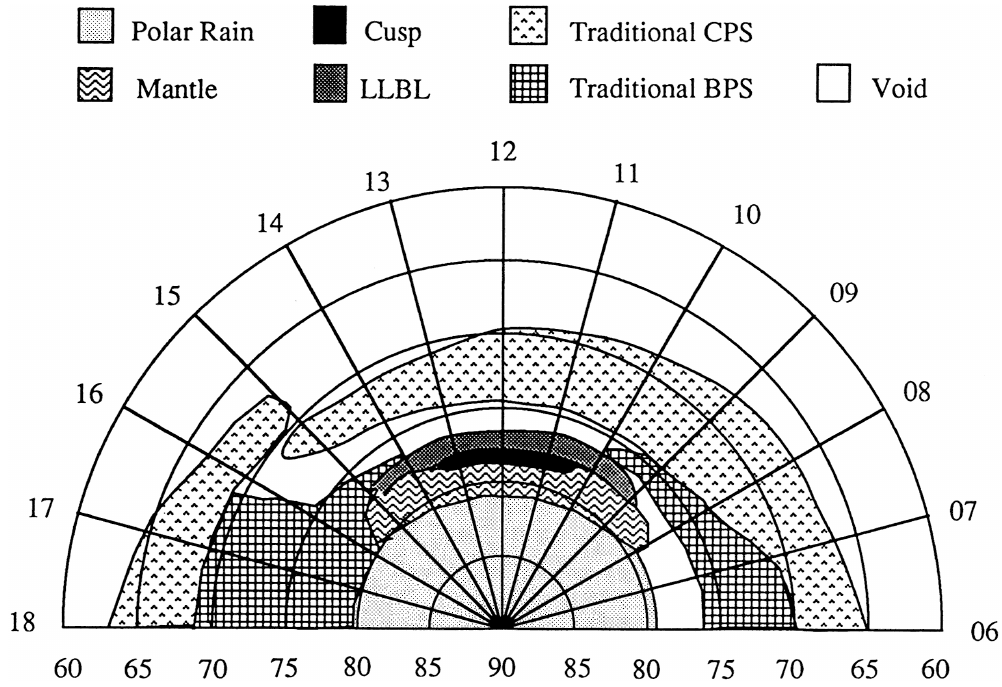
Fig. 1. A map of the ionosphere to the magnetosphere based on plasma characteristics as a function of MLAT and MLT (adapted from Newell and Meng, 1992). Data was taken for all interplanetary conditions (© by American Geophysical